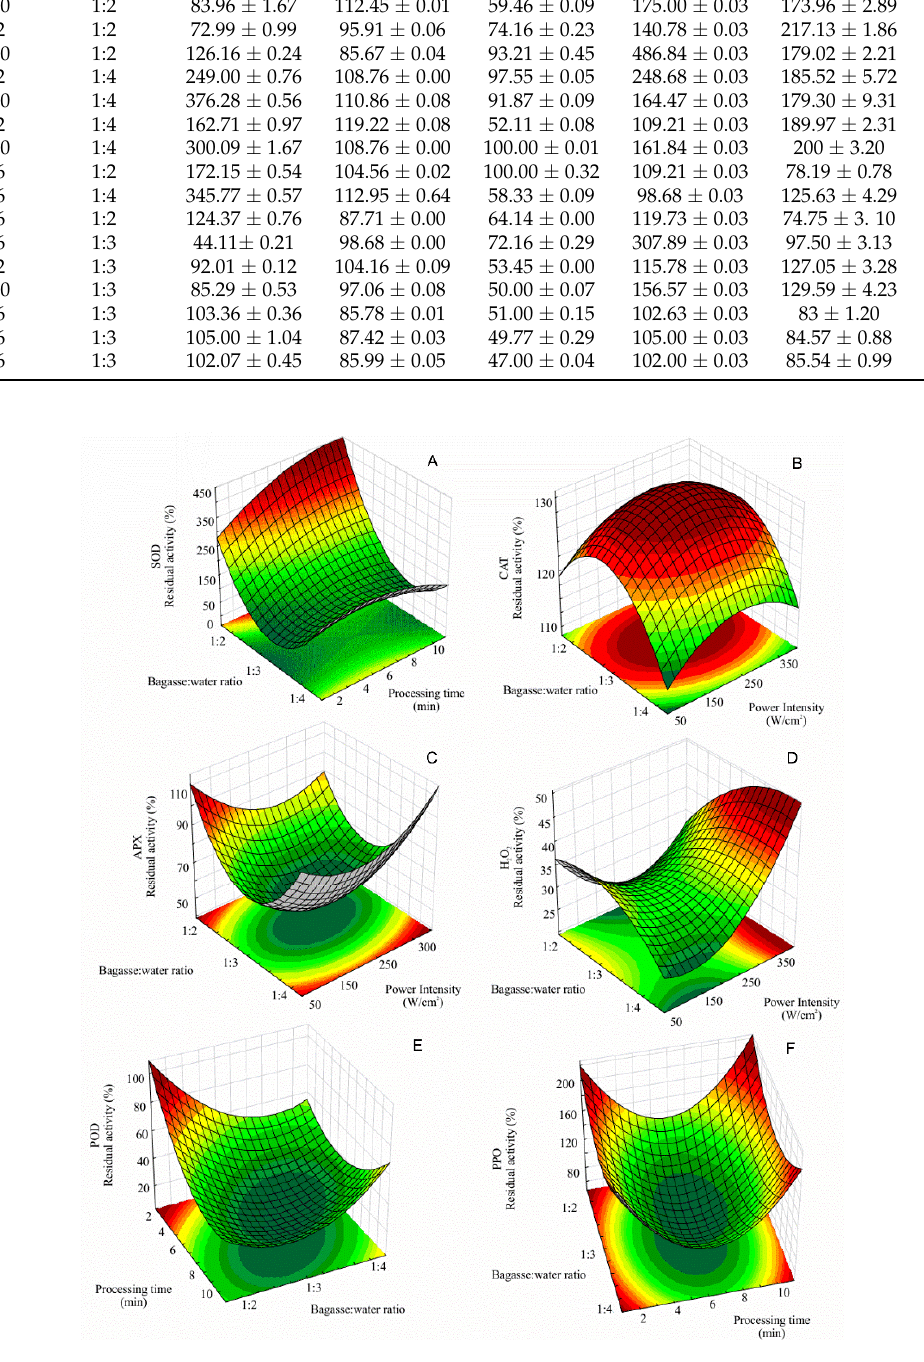
Figure 2. Response surface for the effect of sonication on SOD (superoxide dismutase) ( A ), CAT (catalase) ( B ), APX (ascorbate peroxidase) ( C ), H 2 O 2 content ( D ), POD (peroxidase) ( E ), PPO (polyphenol oxidase) and ( F ), activities of cashew apple bagasse.